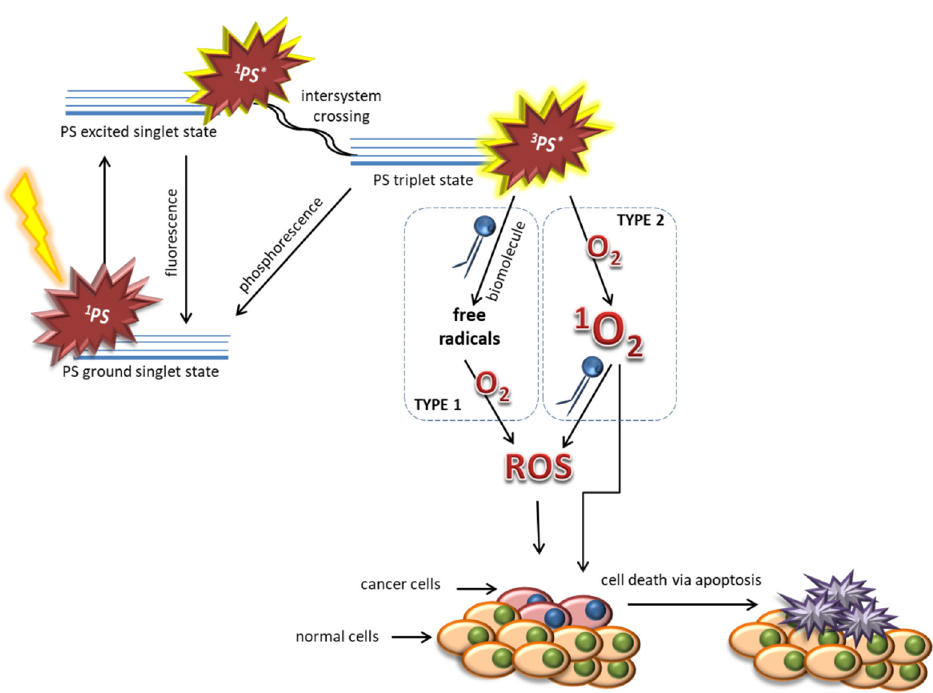
Figure 1. Two possible mechanisms of the photodynamic effect.